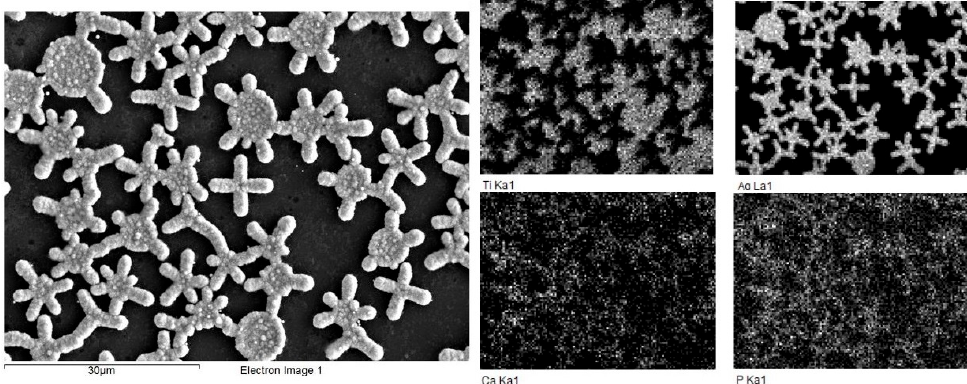
Figure 5. SEM image and element maps of Ti, Ag, Ca, P for TiO 2 /Ag/HAp composite.